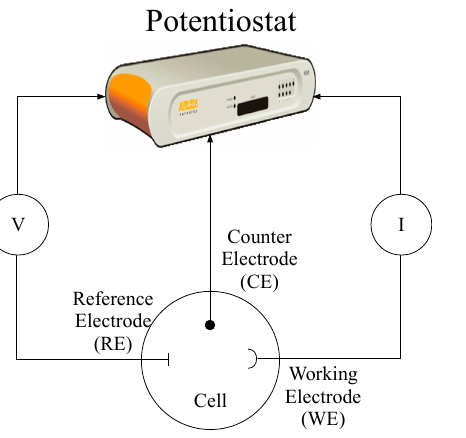
Figure 5. Scheme of the two or three-electrode setup used in electrochemical methods.